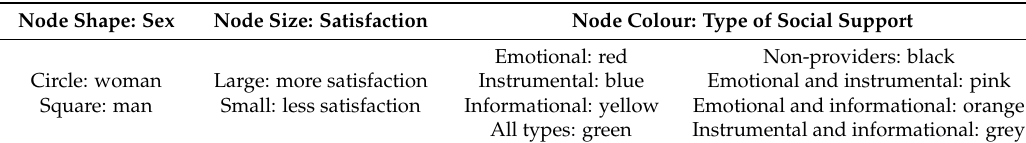
Table 4: Legend of graphs Table 4. Legend of graphs.